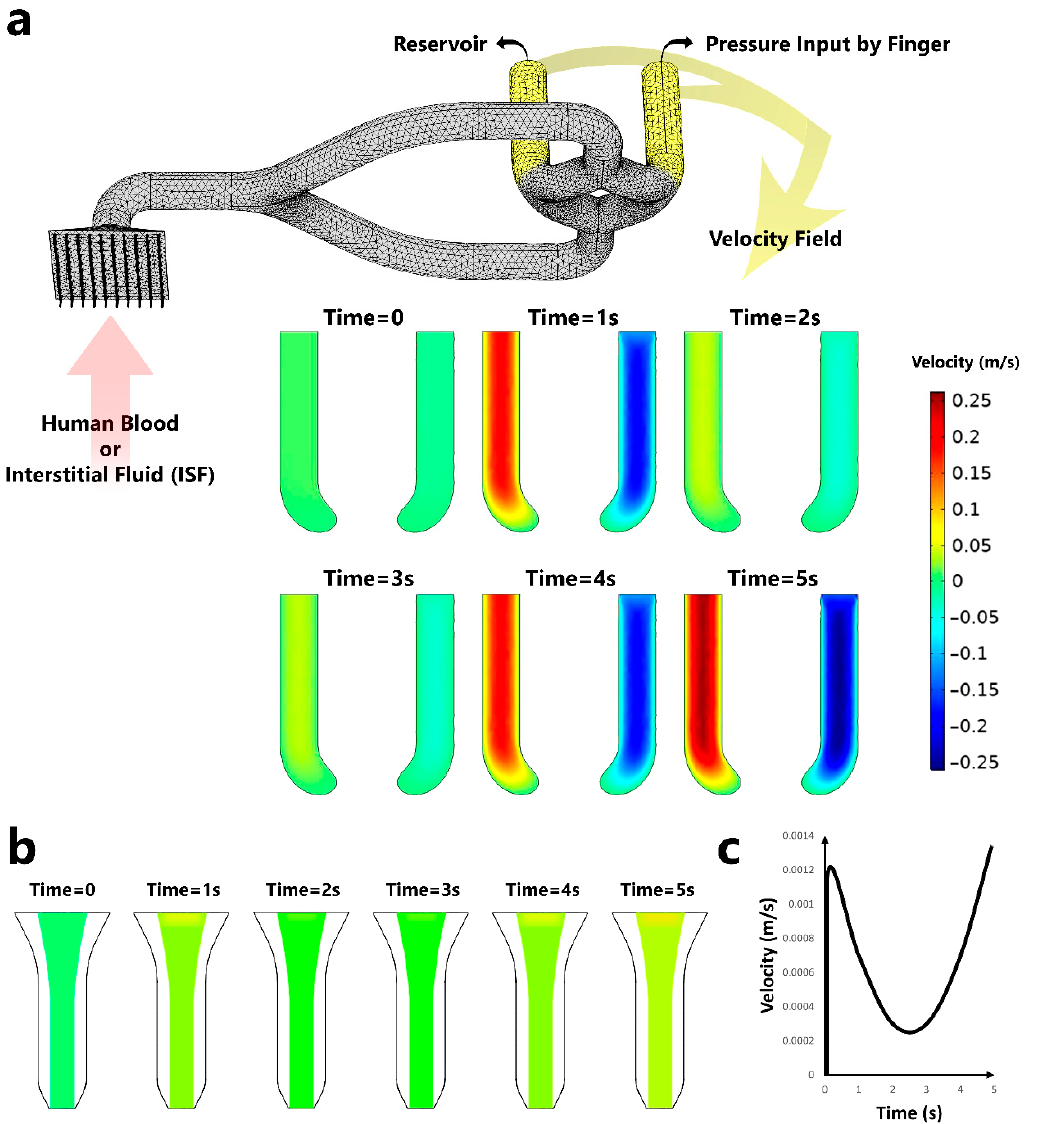
Figure 2. Representation of the created mesh and results of the velocity field. ( a ) The mesh that was created for the study is represented here. In the highlighted area in yellow, the velocity field results in the direction perpendicular to the cross section of the channels are shown, with the function of the heartbeat imitation for the incoming human blood and pressing the mechanical pressure input button every 5 s (study case 3 in Table 3). In the fifth second, the velocity reached its maximum amount of around 0.25 m.s − 1 . ( b ) The velocity field for one of the MNs in the patch from time = 0 to 5 s and ( c ) its corresponding velocity-time curve. The color bar shows velocity in m/s.